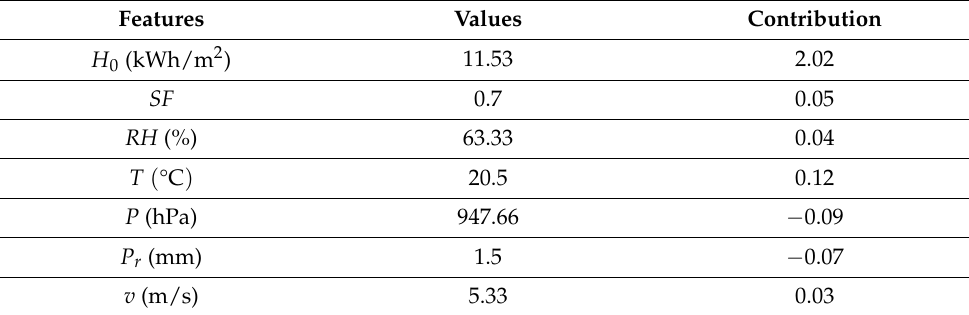
Figure 7. Explanation of the LightGBM model’s output value of 7.20 using SHAP. Table 4. Optimal hyperparameters of SVR and LightGBM models.